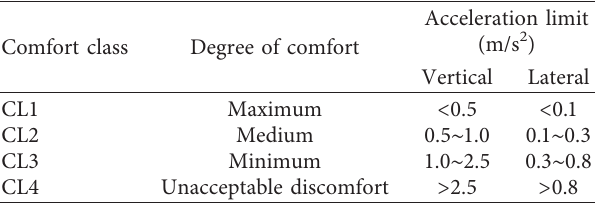
Figure 6: Evaluation limit of the root mean square value of acceleration. Table 2: Evaluation standard of pedestrian